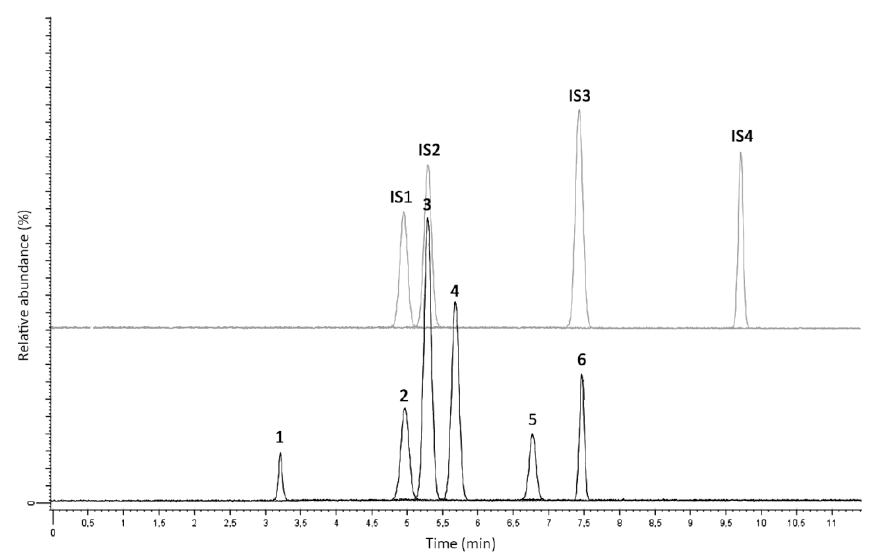
Figure 3. LC-MS / MS chromatogram from a real urine sample spiked with ISs. 1: 1-androstenedione, 2: DHEA, 3: testosterone, 4: epitestosterone, 5: clostebol, 6: DHT.